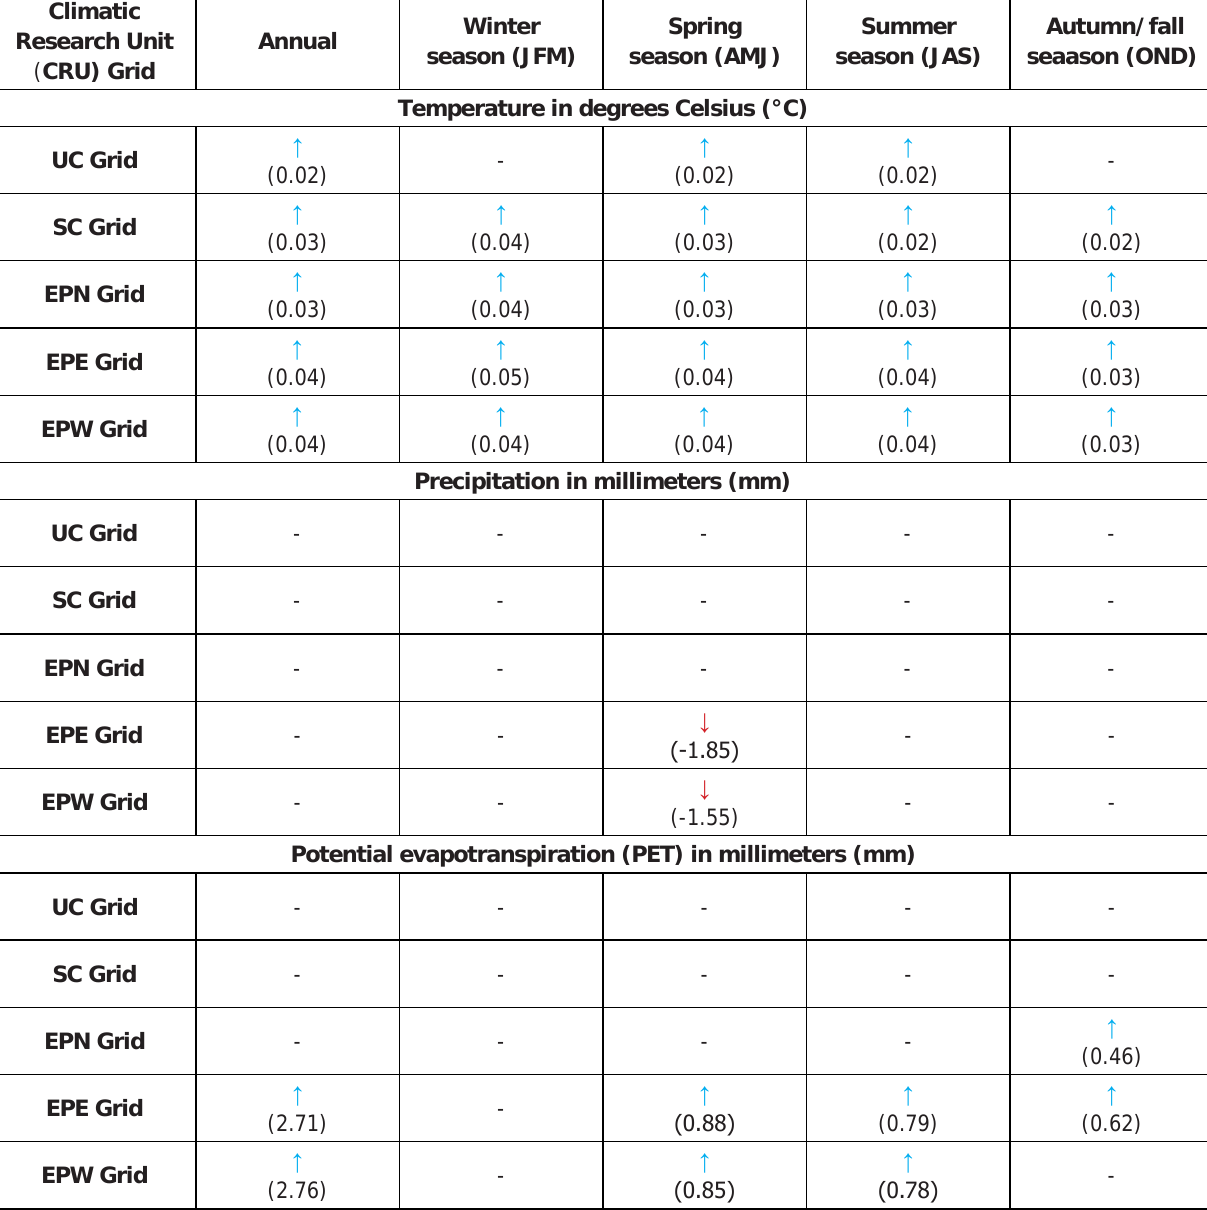
Table 2. Trends in climate data from the CRU dataset for the water year 1970 to water year 2017 period from the